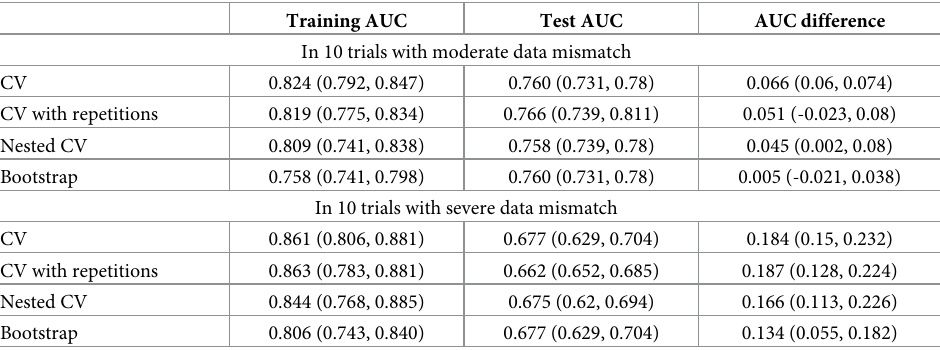
Table 3. Comparison of four methods to estimate model performance in the meningioma grading task.